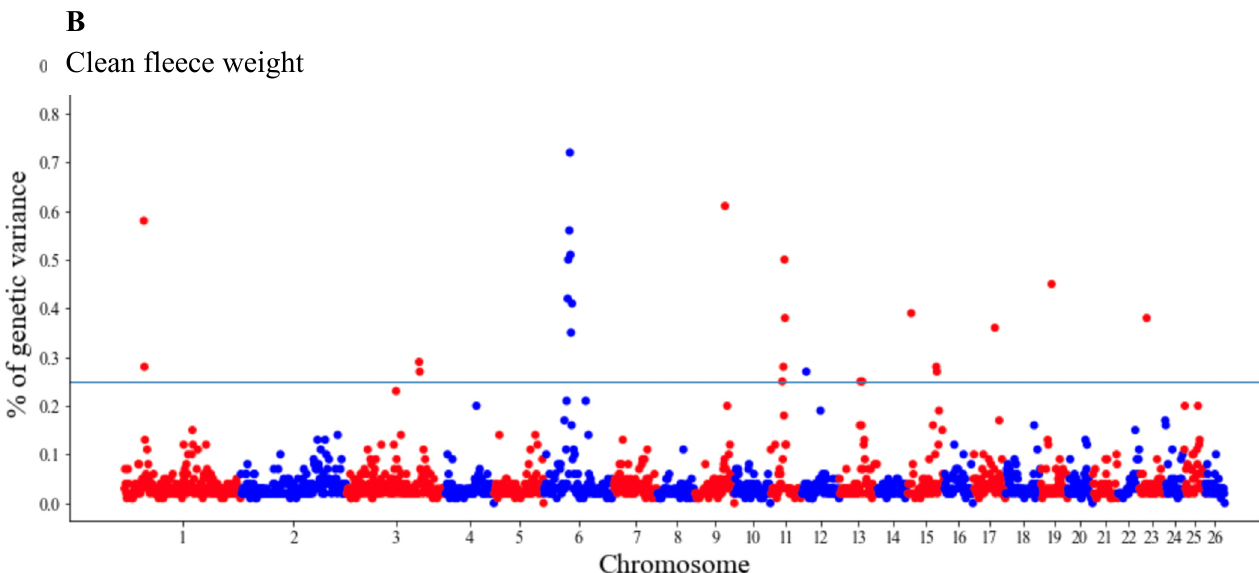
Figure 1. Manhattan plots of the genetic variance explained (%) by 20 adjacent SNP windows for the ewe fiber diameter ( A ) and clean fleece weight ( B ). Each dot represents a window. The % of additive genetic variance explained by each window and chromosomes 1–26 are shown on the Y -axis and X -axis, respectively. The horizontal line indicates the suggestive threshold of 0.25% of the PVE.